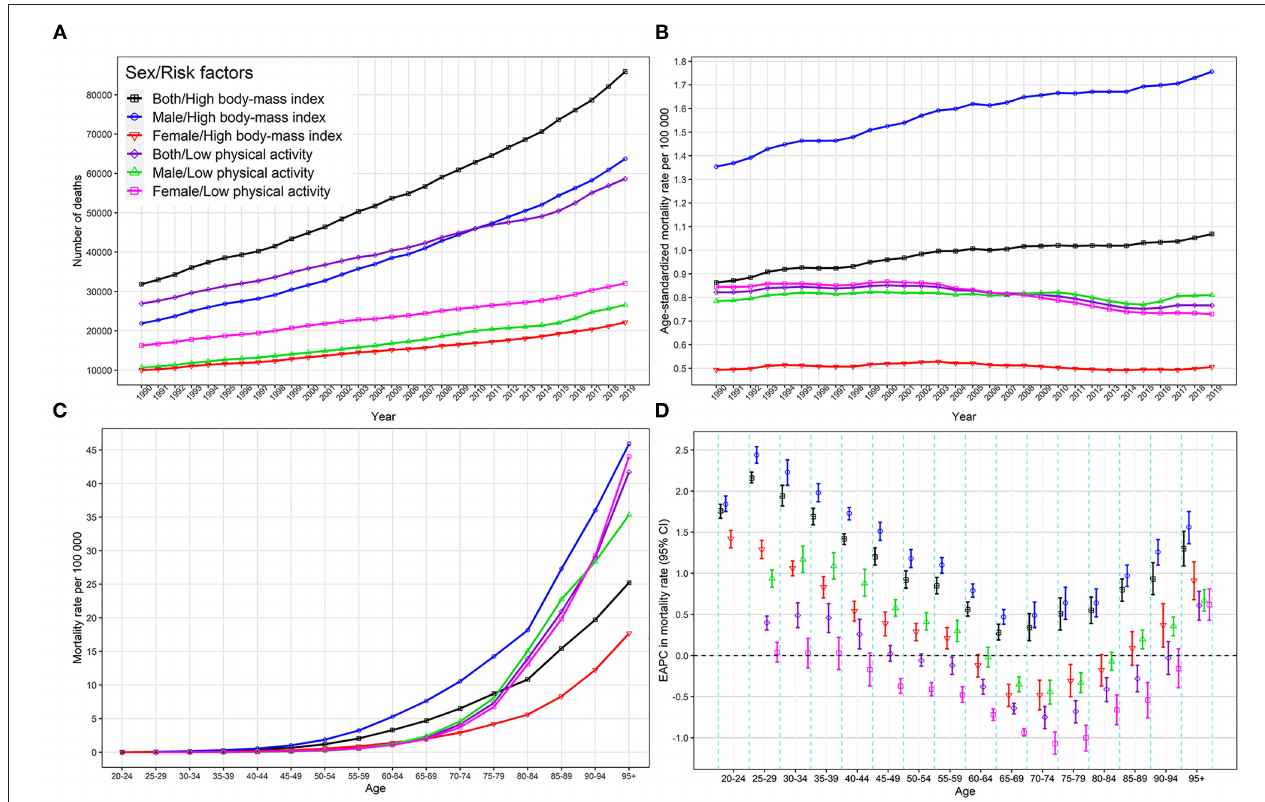
FIGURE 1 | Global colorectal cancer deaths and mortality rates attributable to high BMI and low physical activity. (A) global colorectal cancer deaths, 1990–2019; (B) global colorectal cancer ASMR, 1990–2019; (C) global colorectal cancer mortality rate by age group, 2019; (D) EAPC in global colorectal cancer mortality rate by age group, 1990–2019. ASMR, age-standardized mortality rate; EAPC, estimated annual percentage change; BMI, body mass index.